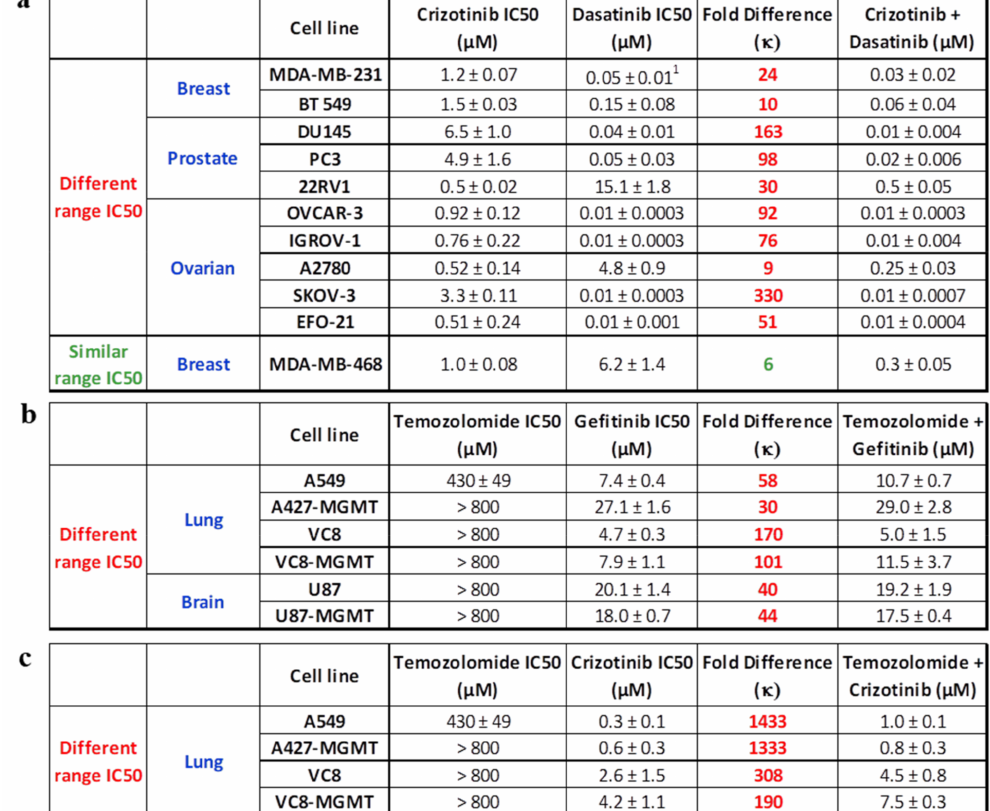
Figure 3. ( a ) IC50 values of growth inhibition assay targeting c-Met and c-Src using crizotinib, dasatinib, and their equimolar combination. ( b ) IC50 values of growth inhibition targeting EGFR and DNA using gefitinib, temozolomide (DNA alkylating agent), and their equimolar combination. ( c ) IC50 values of growth inhibition assay targeting c-Met and DNA using crizotinib, temozolomide, and their equimolar combination. The fold difference between the IC50 values of the two individual drugs is denoted by κ . 1 Rao et al. 2015